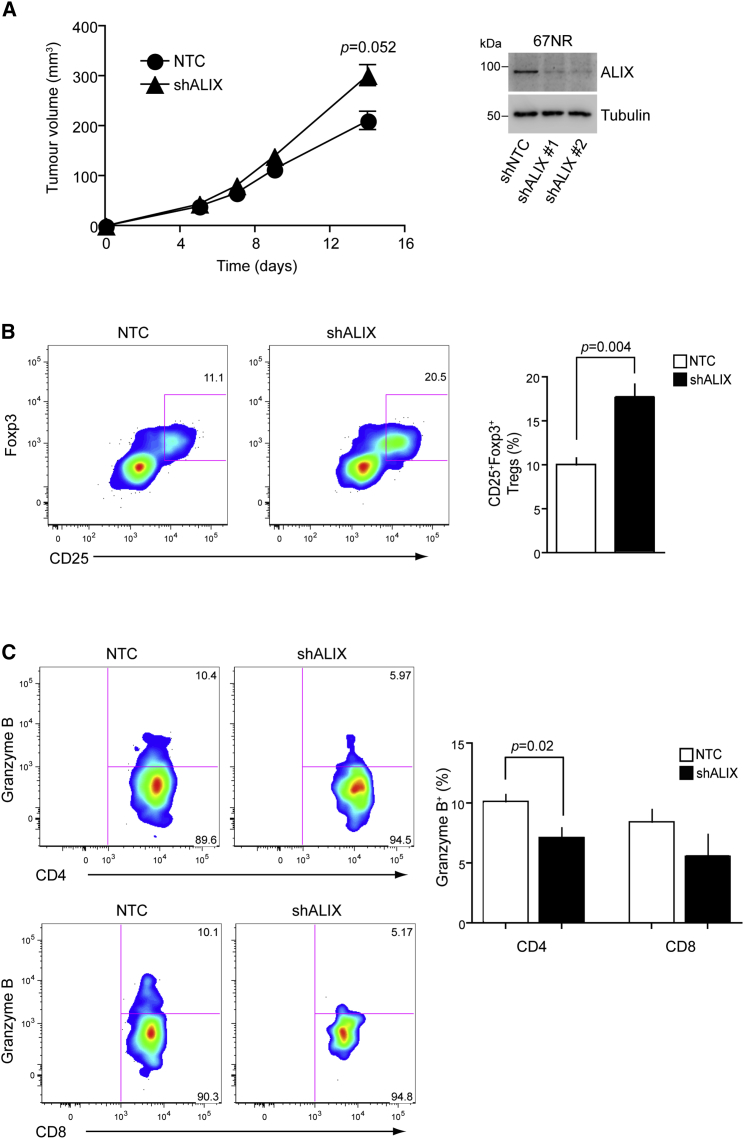
ALIX Deficiency in an In Vivo Model of Breast Cancer Induces an Immunosuppressive Tumor Microenvironment(A) Breast tumors were induced by bilateral subcutaneous injection with control (black circle) or ALIX-KD (black triangle) 67NR cells and were monitored for up to 14 days. Western blot demonstrates stable KD of ALIX in 67NR cell lines.(B and C) Tumor immune cell infiltrate was analyzed for the presence of regulatory T cells (B; Treg, CD4+CD25+Foxp3+) and cytotoxic T cells (C; Granzyme B expression). Plots shown are derived from gates for live CD45+CD3+ cells. The results in the three panels are representative of 8 NTC and 16 short hairpin (sh)ALIX tumors growing in 4 and 9 mice, respectively. Data for the two stable ALIX shRNA 67NR cell lines were pooled for the analysis.